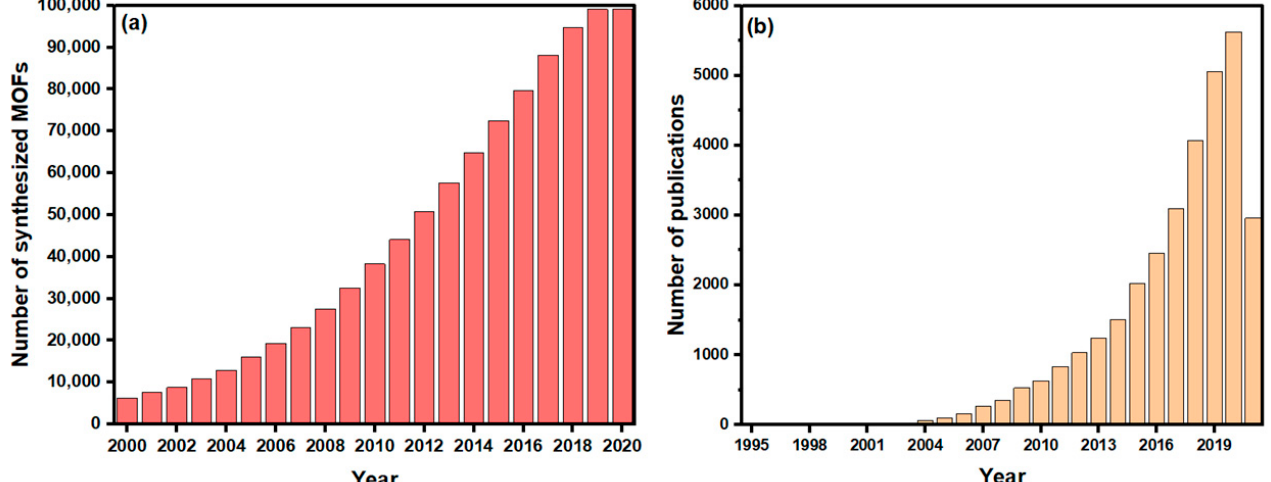
Figure 2. ( a ) The number of synthesized MOFs per year reported in the Cambridge Structural Database (CSD). ( b ) The number of publications per year having the keyword “Metal − organic framework(s)”, retrieved from the Web of Science on 11 July 2021.